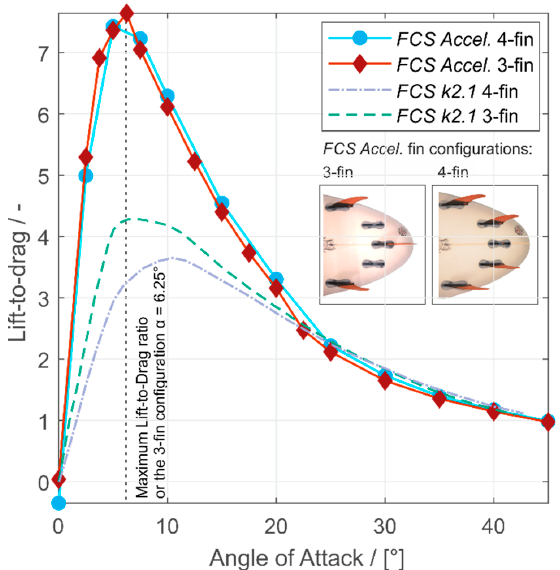
Figure 18. Lift-to-drag ratio versus the angle of attack. The solid lines present the commercial 3- and 4-fin configurations with the FCS Accelerator fins of this study and [11]. The dashed lines present the results of [13] with 3- and 4-fin configurations with plugged FCS k2.1 fins.